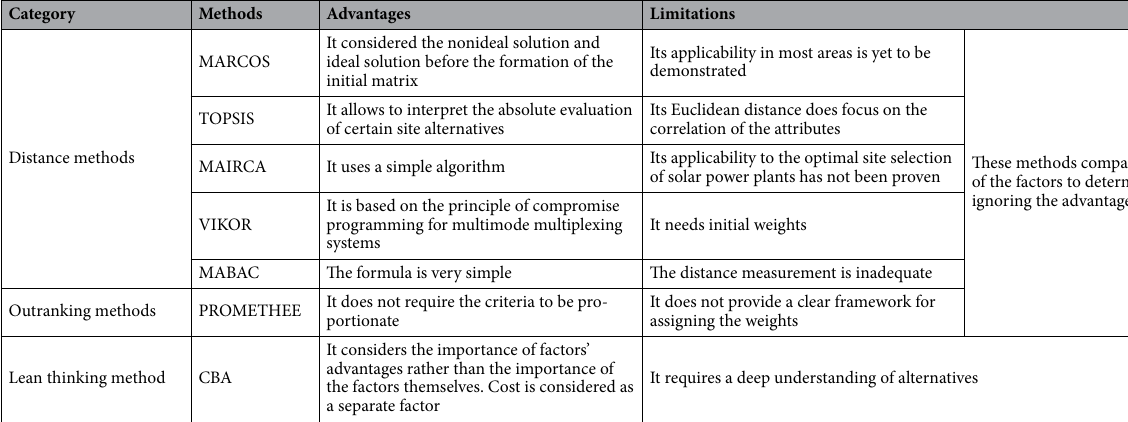
Table 1. The advantages and limitations of several different decision-making methods 31,48,50,51